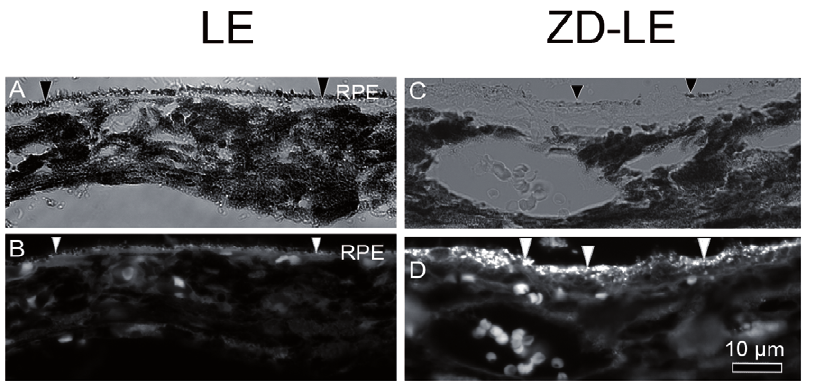
Figure 2. Light microscope and fluorescence micrographs of LE and ZD-LE rats. A ) Bright-field image of melanin pigmentation in LE rat. B ) Auto-fluorescence of lipofuscin and melanolipofuscin pigmentation of the same area as in (A). C ) Bright-field image of melanin pigmentation in ZD-LE rat. D ) Auto-fluorescence of lipofuscin and melanolipofuscin pigmentation of the same area as in (C). In LE rats, the RPE contains a high content of melanosomes (black arrowheads, A) and a low content of lipofuscin (white arrowheads, B). In contrast, in ZD-LE rats, the RPE contains a low content of melanosomes (black arrowheads, C) and a high content of lipofuscin (white arrowheads, D).